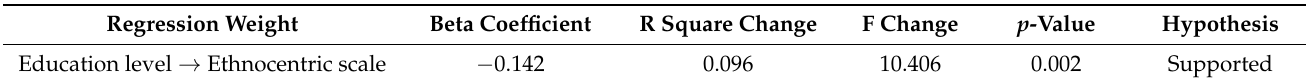
Table 10. Regression analysis of means of ethnocentric scale and academic education level of partici-